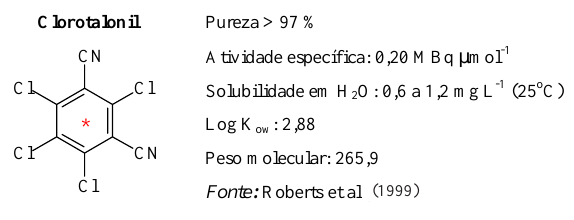
Figura 1. Características físico-químicas do